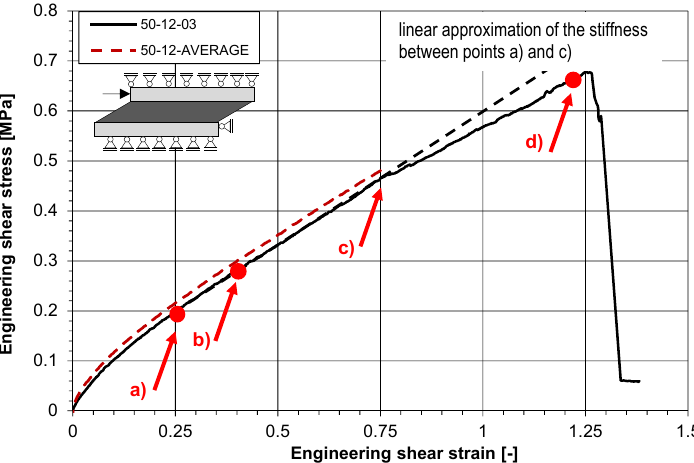
Fig. 15 Engineering stress-strain curve in shear for the 50-12-03 specimen and average curve for the test series 50-12 plotted.